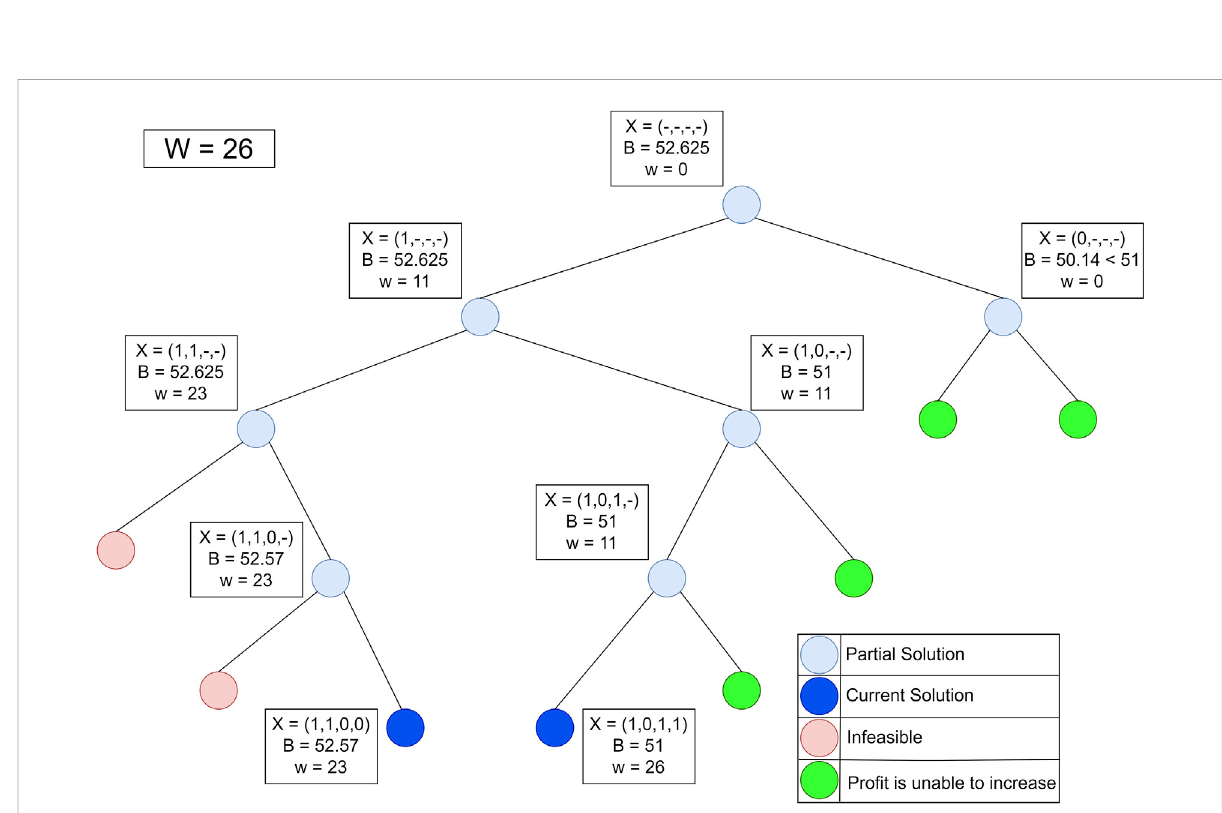
FIGURE 5 Lower bounds pruning